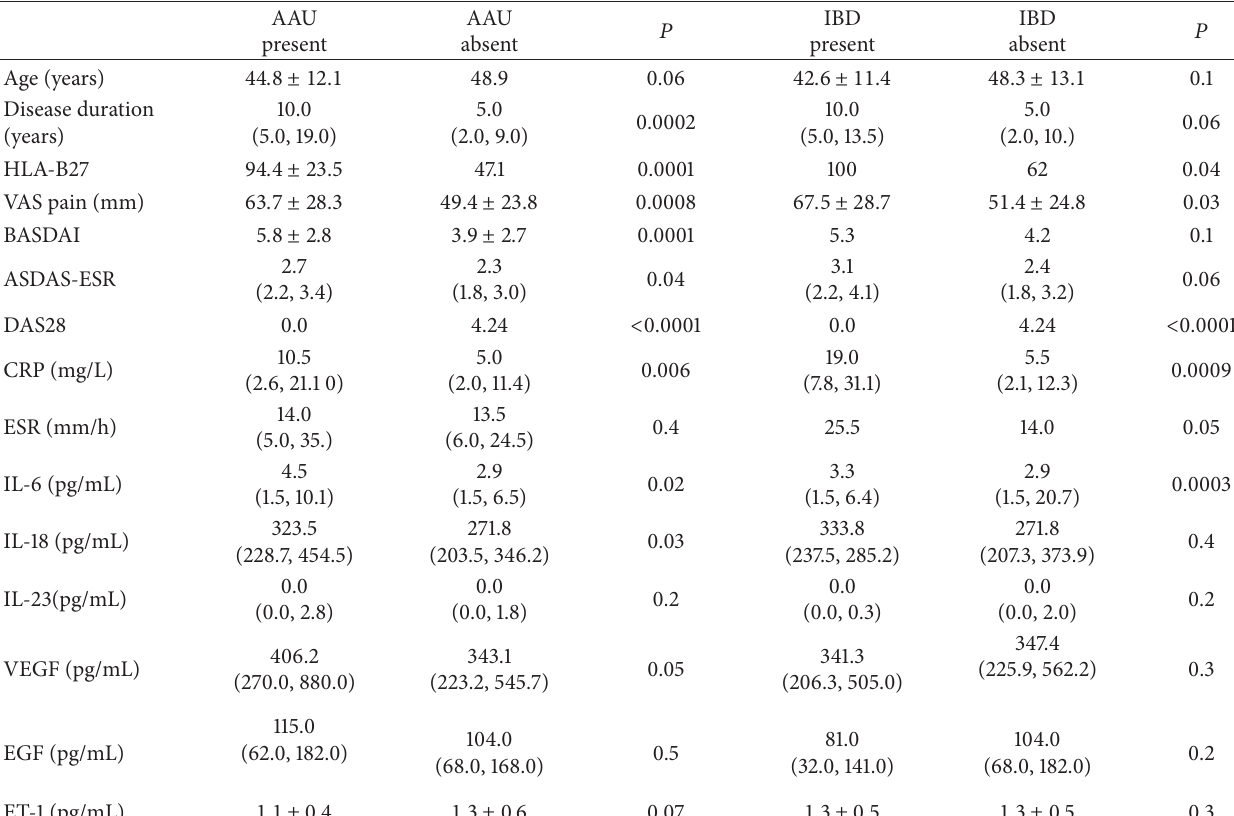
Table 2: Comparison of serum levels of selected cytokines and markers of disease activity in spondyloarthritis patients with and without acute anterior uveitis and inflammatory bowel